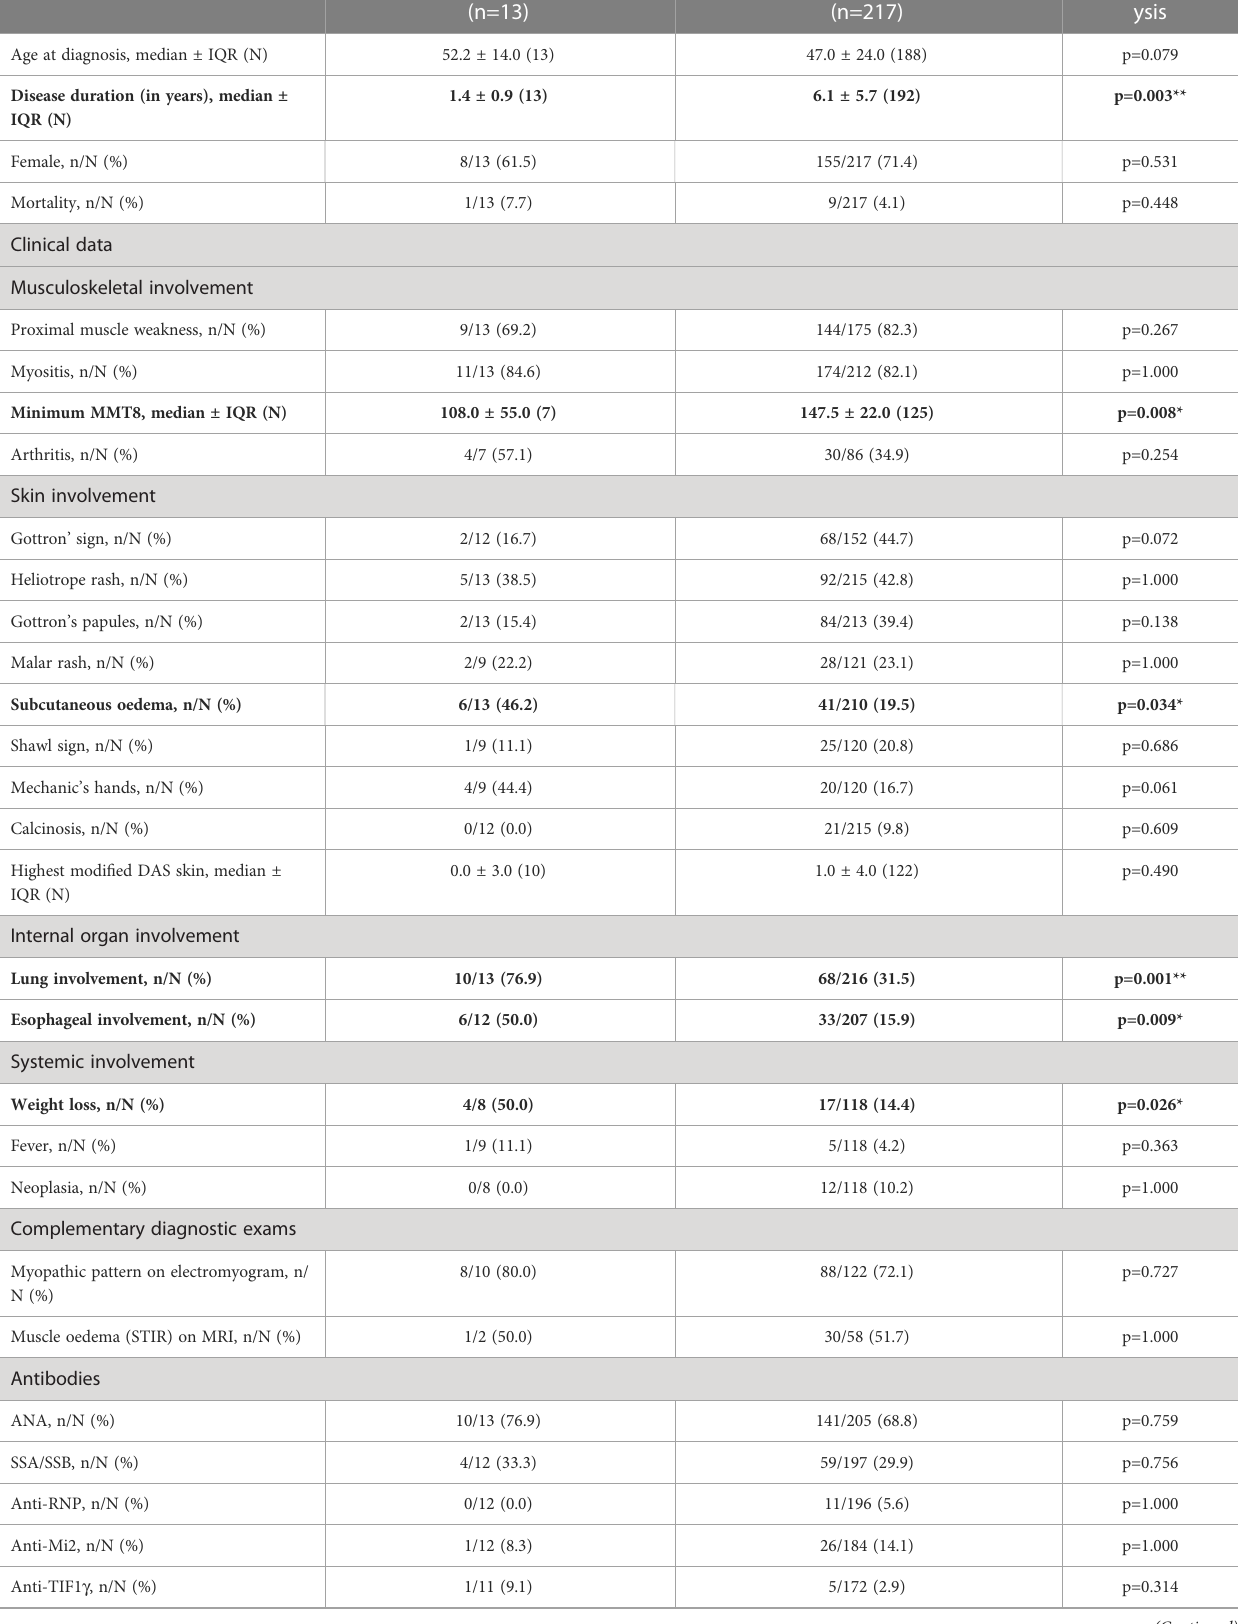
TABLE 1 Clinical and serological features of patients with and without cardiac